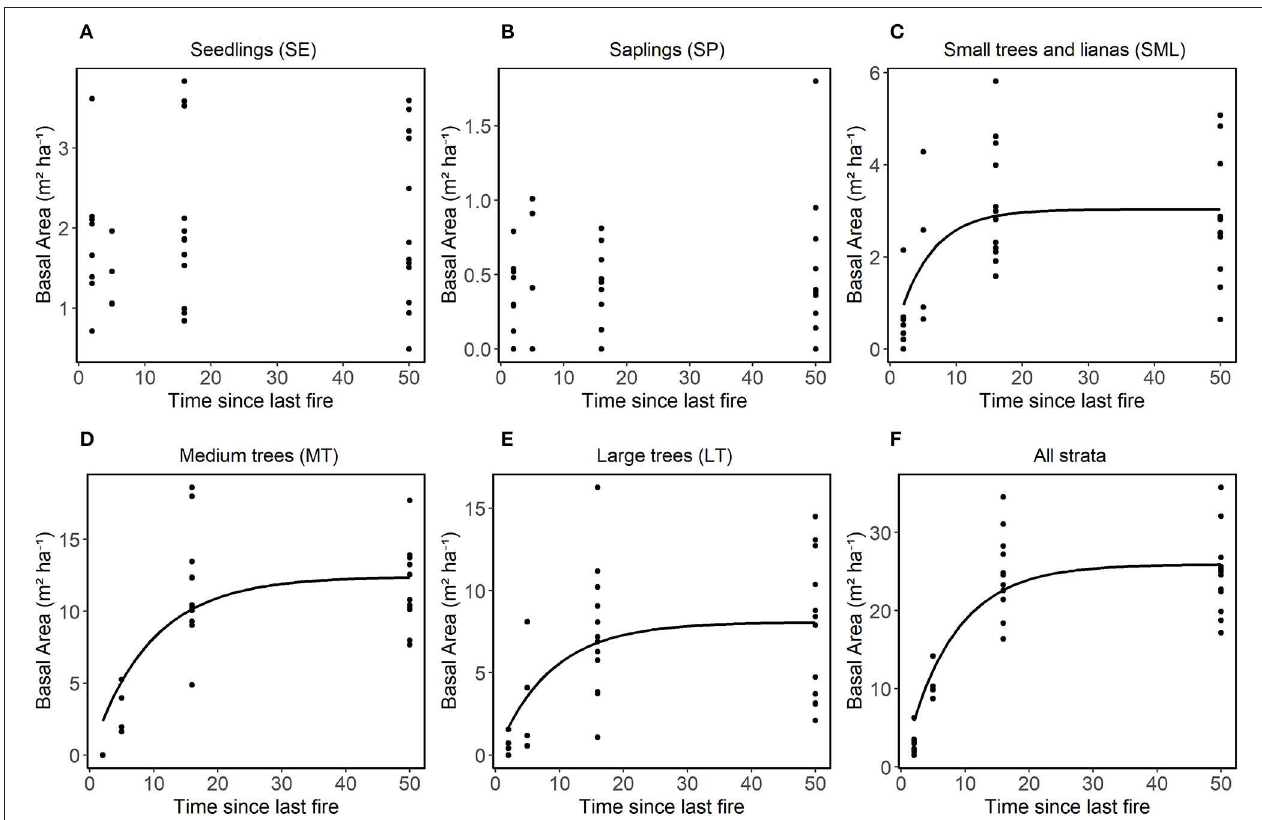
FIGURE 6 | Relationship in each stratum between basal area (m ² ha − 1 ) and time since last fire. Non-linear models adjusted using the procedure (nls in R) with asymptotic models, the equation was performed separately for each stratum of vegetation (A) SE, (B) SP, (C) SML, (D) MT, (E) LT, and (F) for all strata together. LT stands for large trees, MT for medium trees, SML for small trees and woody lianas, SP for seedlings and SE for seedlings. Only curves that showed significant differences were